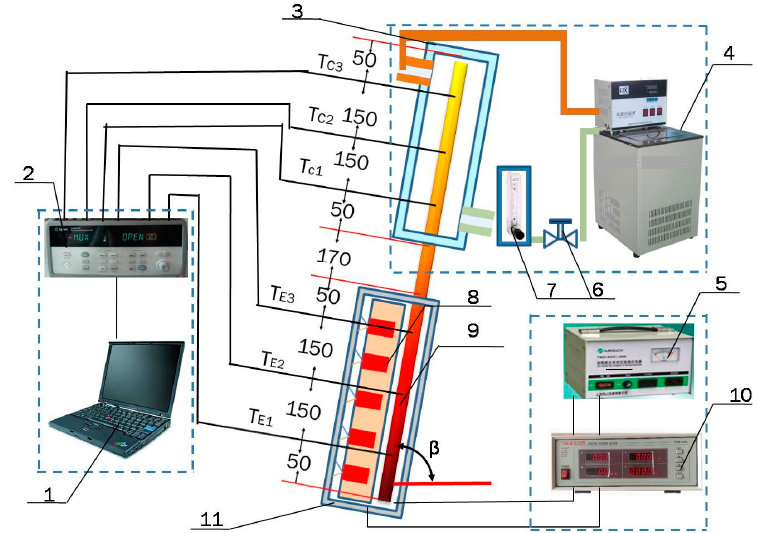
Figure 5. Experimental test setup to characterise the MF-AHPA thermal resistance. 1. PC 2. Agilent 34970A 3. Cooling water jacket 4. Thermostatic tank 5. Constant voltage source 6. Valve 7. Float flowmeter 8. Heating bars 9. MF-AHPA 10. Heat input meter 11. Insulating blanket. Table 4. Working ranges and errors of key instruments.